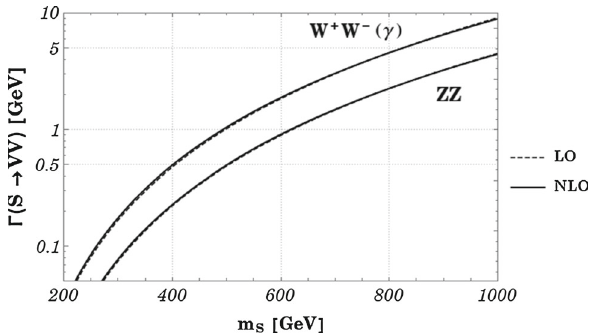
Fig. 5 Leading order (dashed line) and next-to-leading order (solid line) results for (cid:6)( S → V V ) ( s α = 0 . 17, w = 4 . 34 v ). In the case of V = W the photon momenta is fixed to q γ = q max